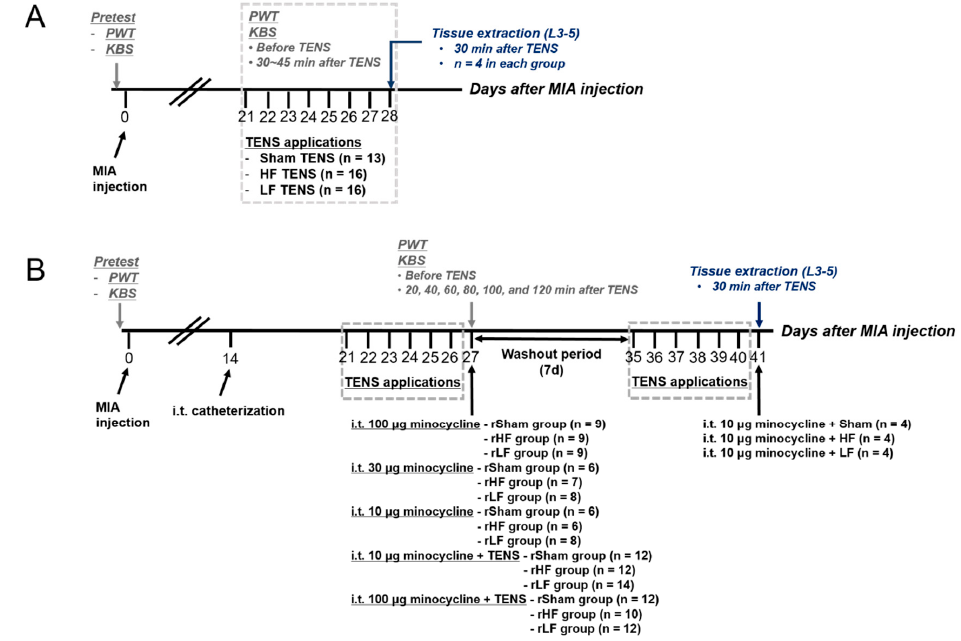
Figure 1. Diagram of the timelines of the two experiments ( A ) Experimental design for the effect of repeated transcutaneous electric nerve stimulation (TENS) application on osteoarthritic pain and changes in the expression of spinal microglia in rats with oseteoarthritis. ( B ) Experimental design for the effect of microglia inhibition or TENS with microglia inhibition on osteoarthritic pain changes in the expression of spinal microglia in TENS-tolerant rats. PWT, paw withdrawal threshold; KBS, knee bend test; MIA, monosodium iodoacetate; HF, high frequency; LF, low frequency; rHF, rats developed tolerance to the analgesic effect of TENS due to repeated HF TENS applications; rLF, rats developed tolerance to the analgesic e ff ect of TENS due to repeated LF TENS applications; rSham, rats with repeated sham TENS applications (no tolerance development).